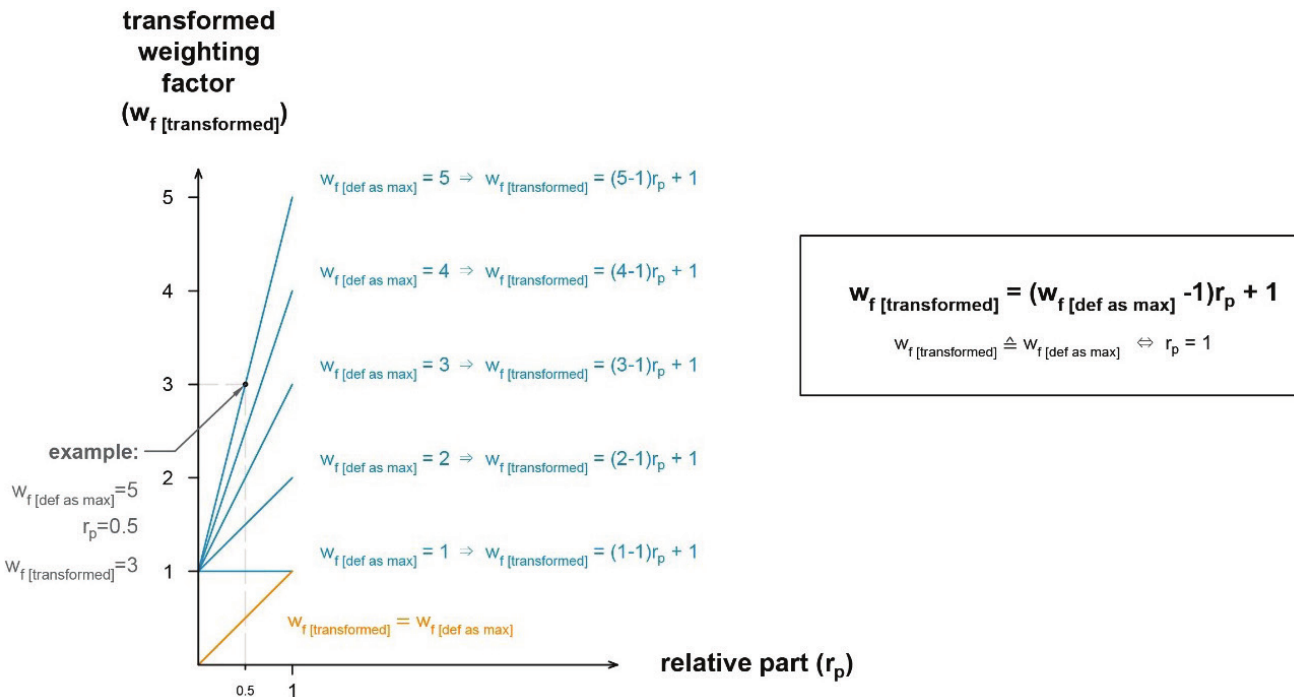
Figure 5 Calculation of transformed weighting factor (wf [transformed]) based on the relative part (rp) of each landscape element. The maximum weighting factor (wf [def as max])